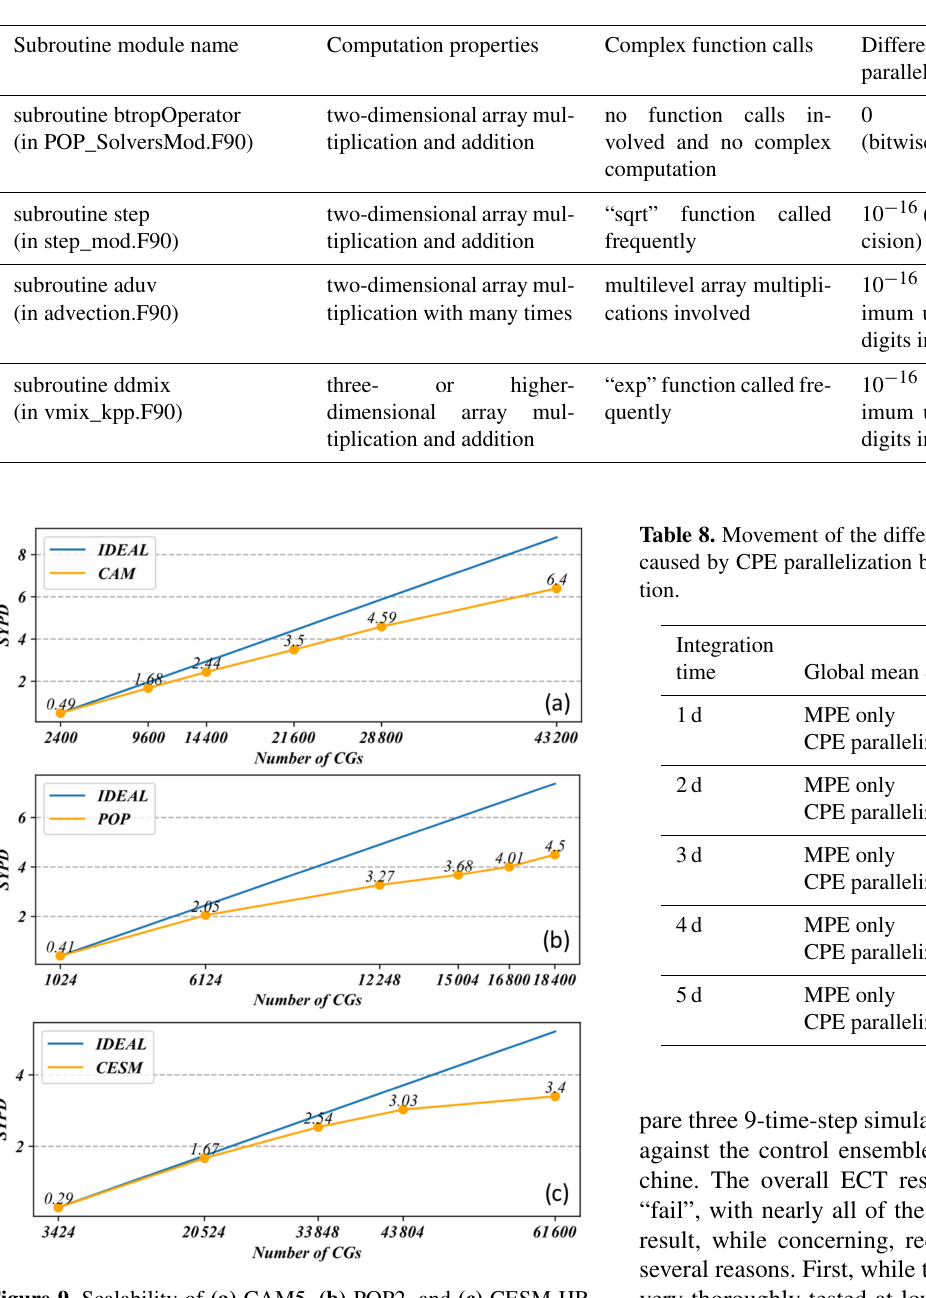
Table 7. List of refactoring and optimizing schemes for POP2 computing hotspots.